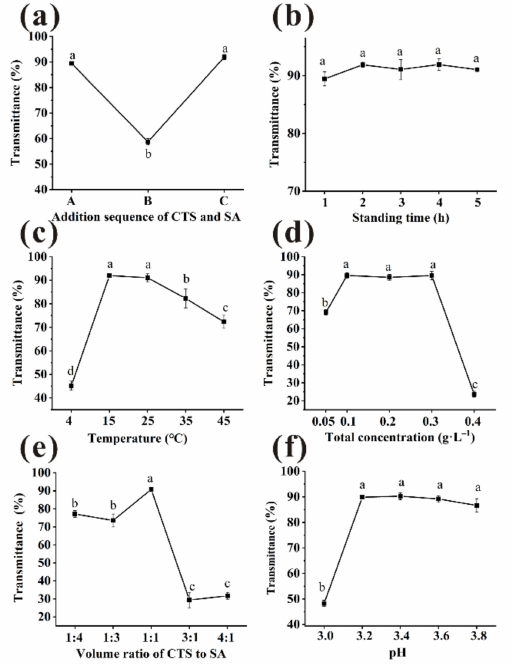
Figure 2. Various factors (( a ): addition sequence, ( b ): standing time, ( c ): temperature, ( d ): total concentration, ( e ): volume ratios, ( f ): pH) to influence the transmittance of bayberry juice. (Different little letters mean a significant difference at the level of